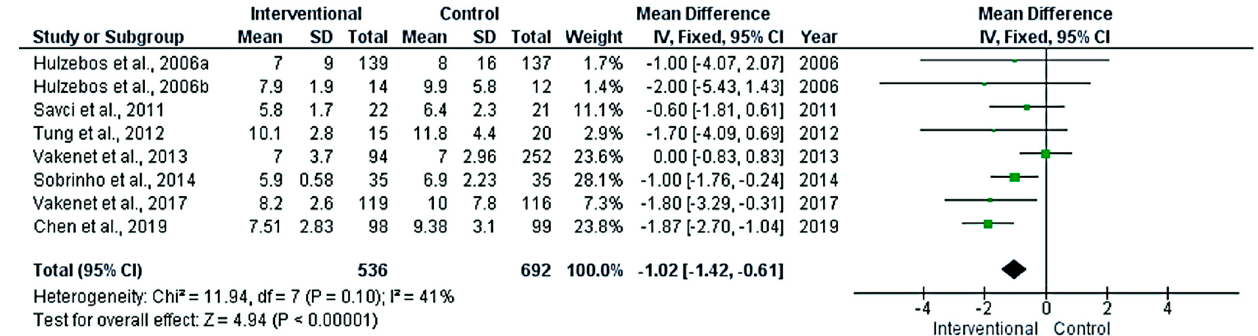
Figure 4. Forest plot evaluating mechanical ventilation duration in the included studies.